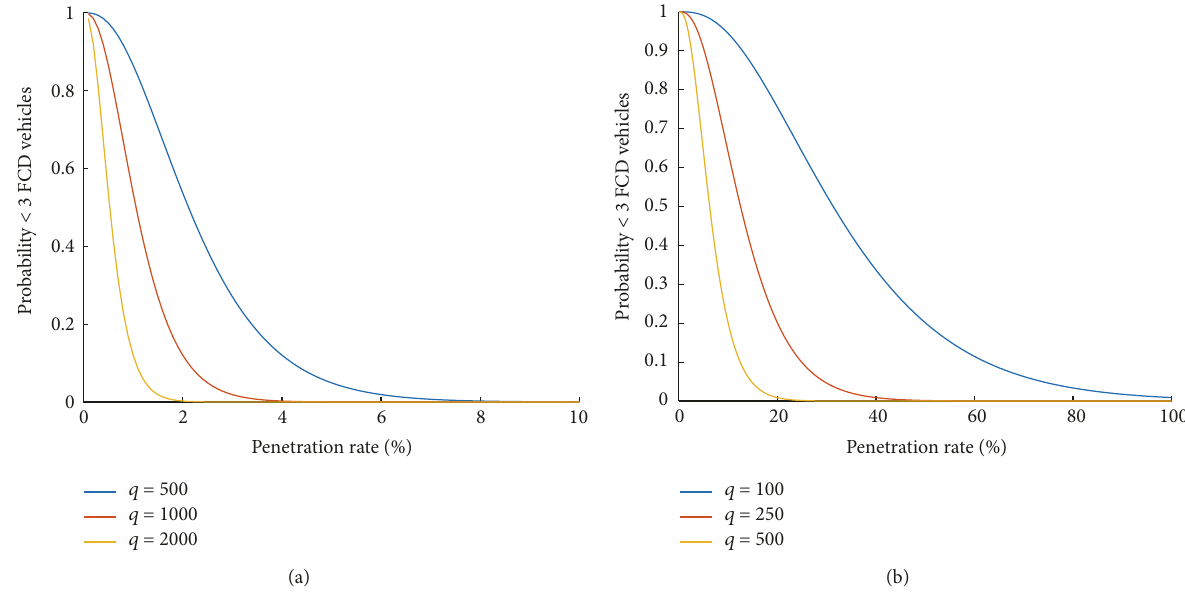
Figure 7: Estimation of the probability that less than 3 FCD vehicles are observed during a 5-minute time interval on a road section of 100m length and different lane flows ( 𝑞 ), on a 3-lane motorway with speed limit 120 km/h (a), and on a one-lane urban road with speed limit 50 km/h